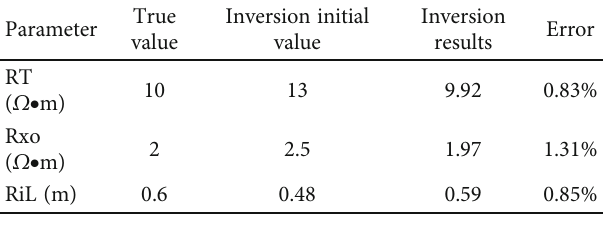
Table 1: Evaluation of the inversion results.